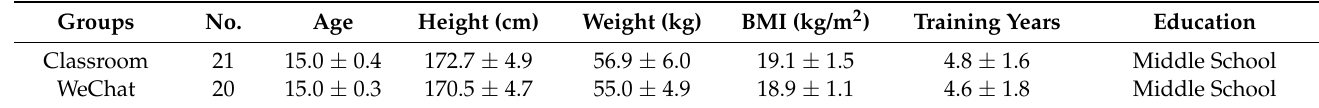
Table 2. Approved study subject characteristics (N =